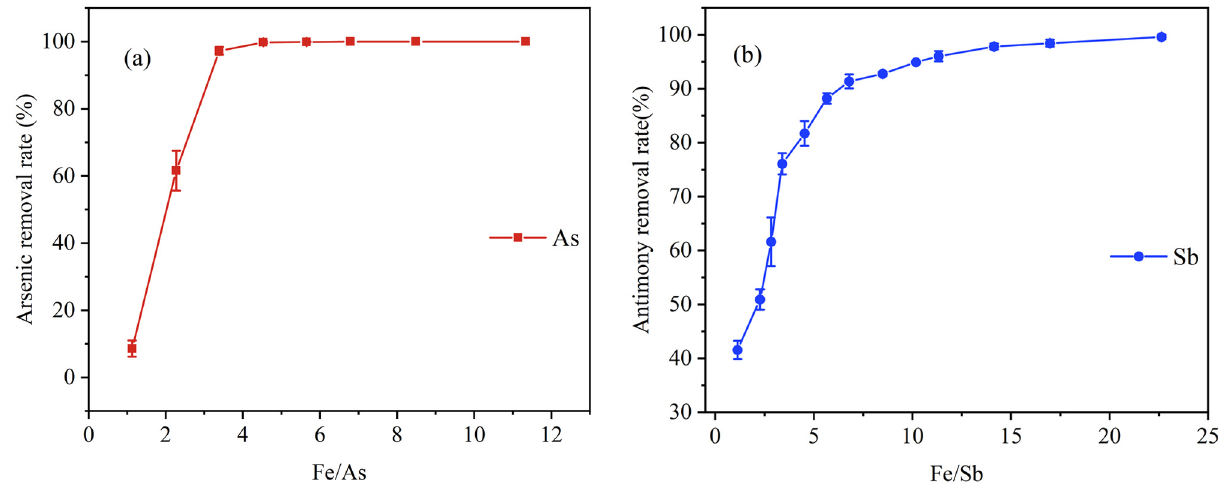
Figure 1. ( a ) Effect of Fe/As mass ratio on removal of individual arsenic, initial As(III) = 0.5 mg/L pH = 6.5 ( b ) Effect of Fe/Sb mass ratio on removal of individual antimony, initial Sb(III) = 0.5 mg/L pH = 4.5.